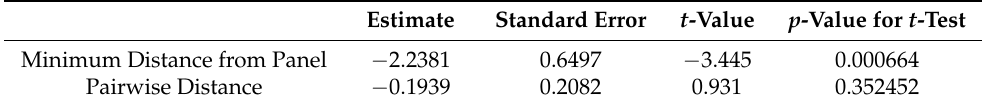
Table 3. The linear regression results, testing for statistically significant effects of the minimum distance from the reference panel and the pairwise distance of mixed haplotypes on deconvolution accuracy.